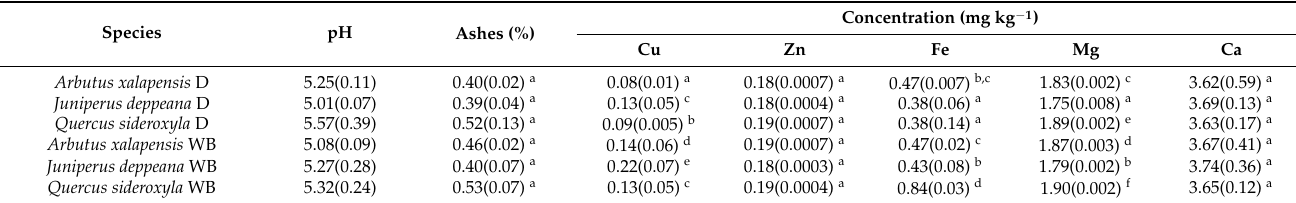
Table 2. Average percentage of extracts and wood components of the species evaluated.